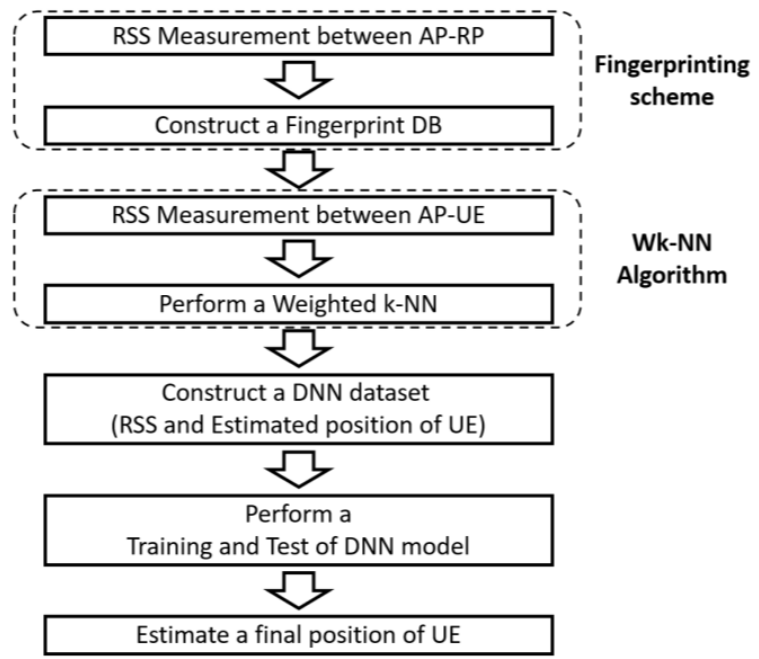
Figure 5. Block diagram of proposed system.